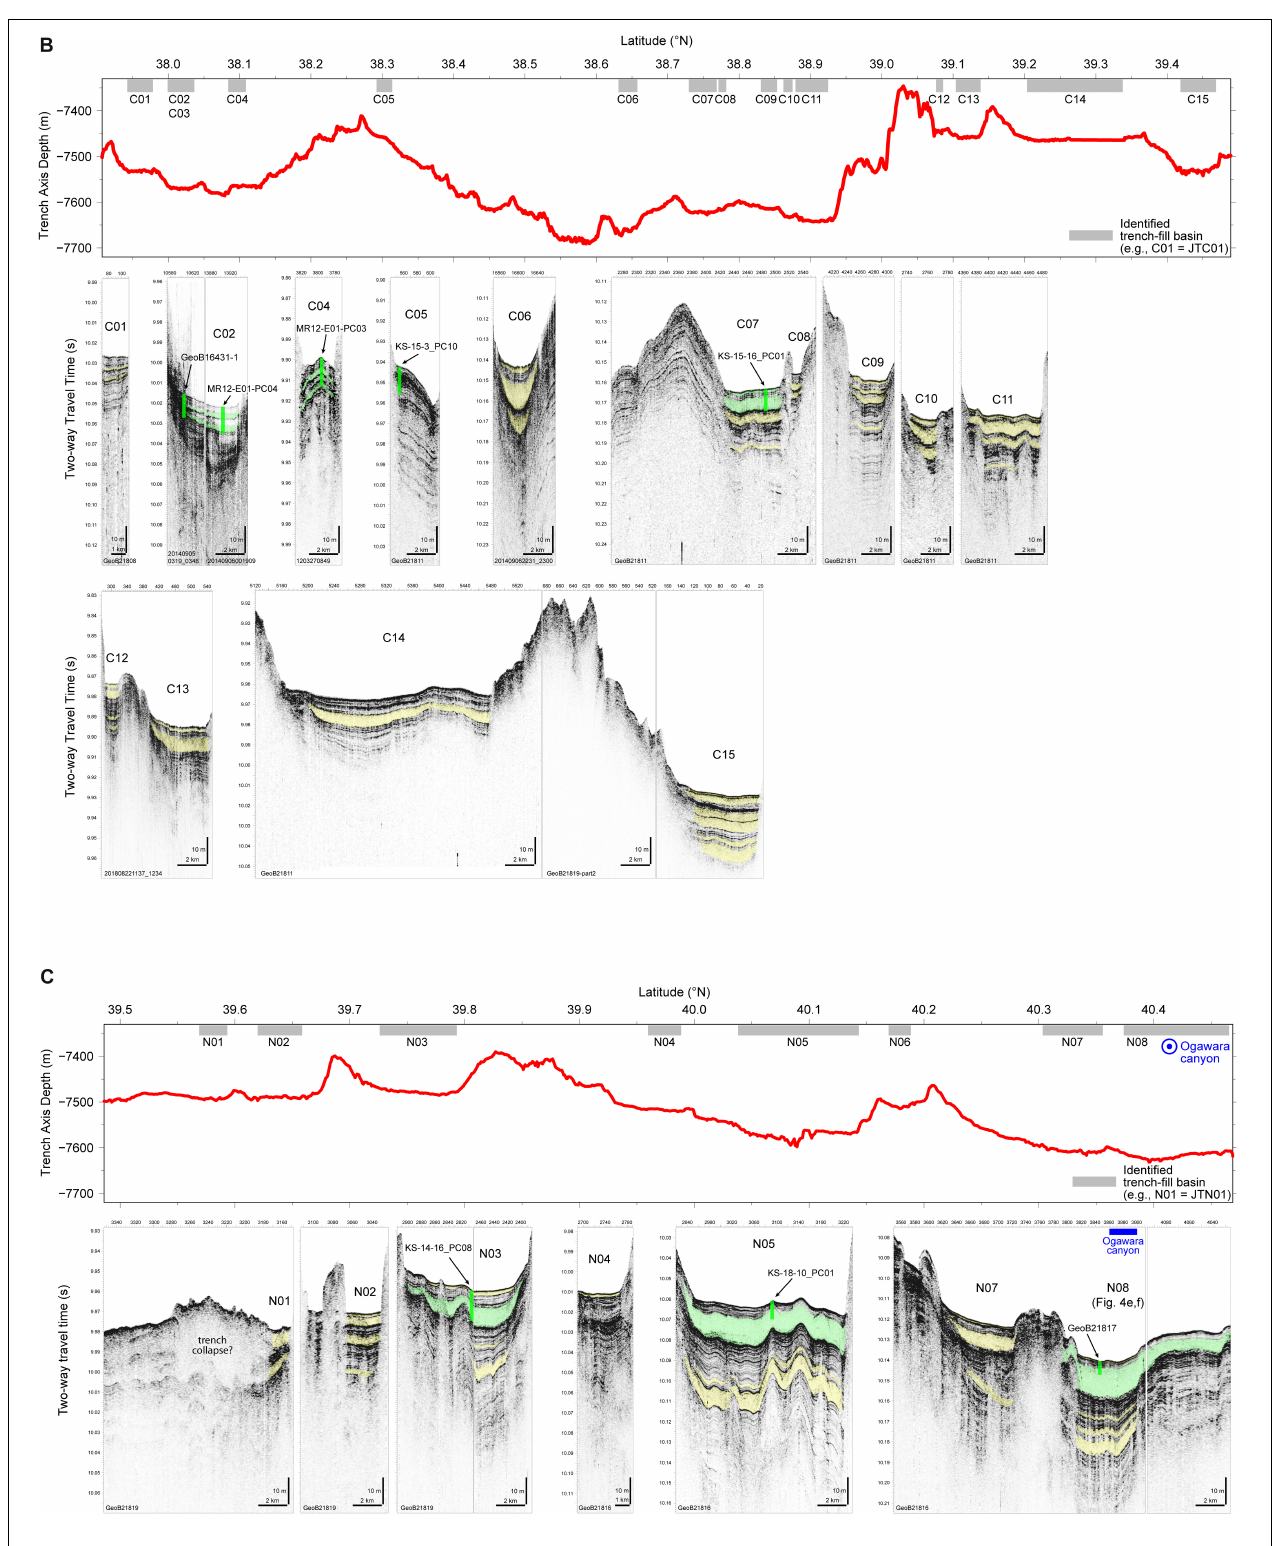
FIGURE 3 | Water depth, identified trench-fill basins, and their SBP images along the trench axis of (A) southernJapan Trench, (B) central Japan Trench, and (C) northern Japan Trench. Yellow fills are identified acoustically transparent event bodies based solely on SBP data, whereas green fills are the acoustically transparent event bodies validated by sediment